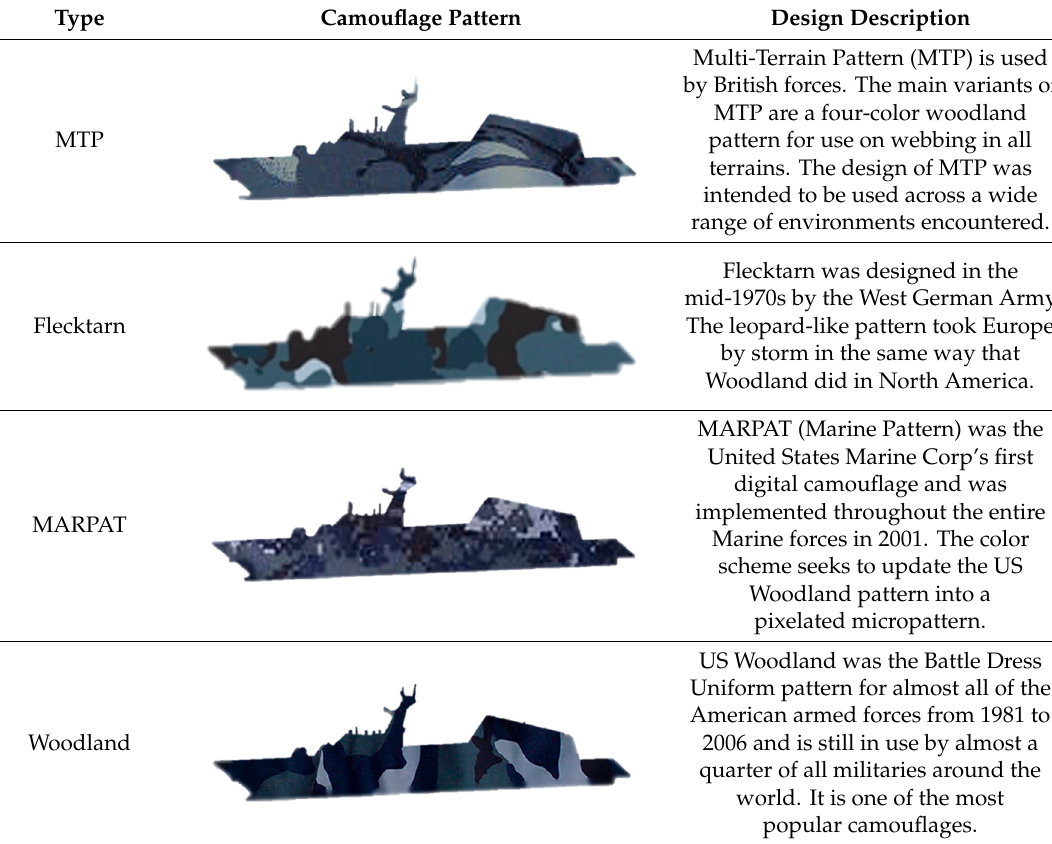
Table A1. Six camouflage types.